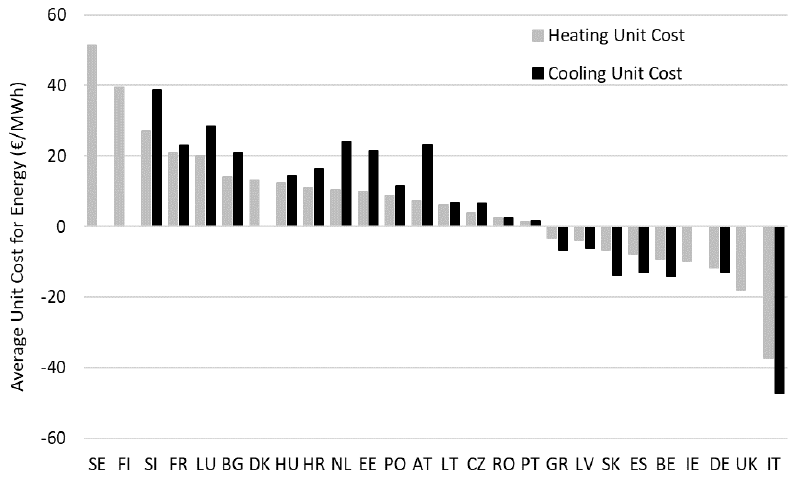
costs. Figure 7 maps this parameter space in two dimensions: countries with low energy requirements and energy costs (bottom left corner) had favorable conditions for cultivation, while countries in the top right corner had high costs associated with cultivation as a result of market and weather conditions.